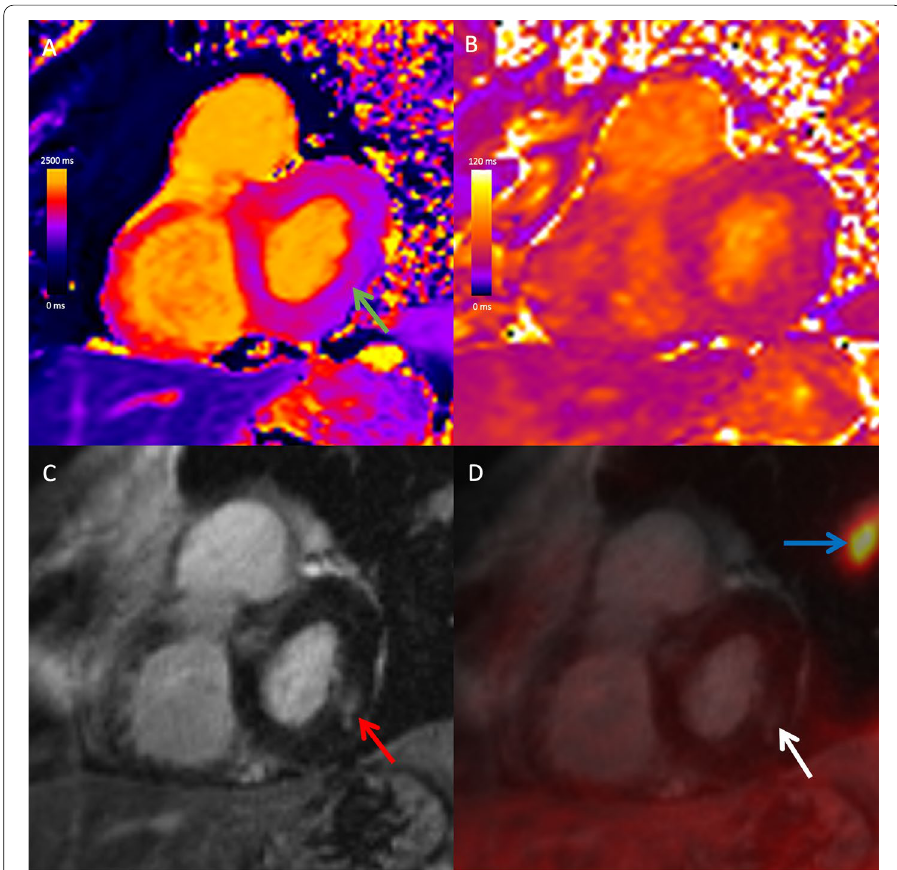
Fig. 2 Combined 18F‑FDG PET/MRI images in a 72‑year‑old male with cardiac and extra‑cardiac sarcoidosis. Basal short‑axis native T1 map ( A ), native T2 map ( B ), late gadolinium‑enhanced (LGE) image ( C ), and fused 18F‑FDG PET and LGE image ( D ) demonstrate slightly elevated native T1 (green arrow) and corresponding mid‑wall LGE (red arrow) at the basal inferolateral wall. There was no corresponding elevation of native T2 or focal FDG uptake (white arrow). There was extra‑cardiac FDG uptake in mediastinal and hilar lymph nodes (not shown) and in the lung parenchyma (blue arrow) in keeping with extra‑cardiac sarcoidosis. With respect to the heart, the study was negative on PET and positive on MRI, likely reflecting chronic, burnt‑out cardiac